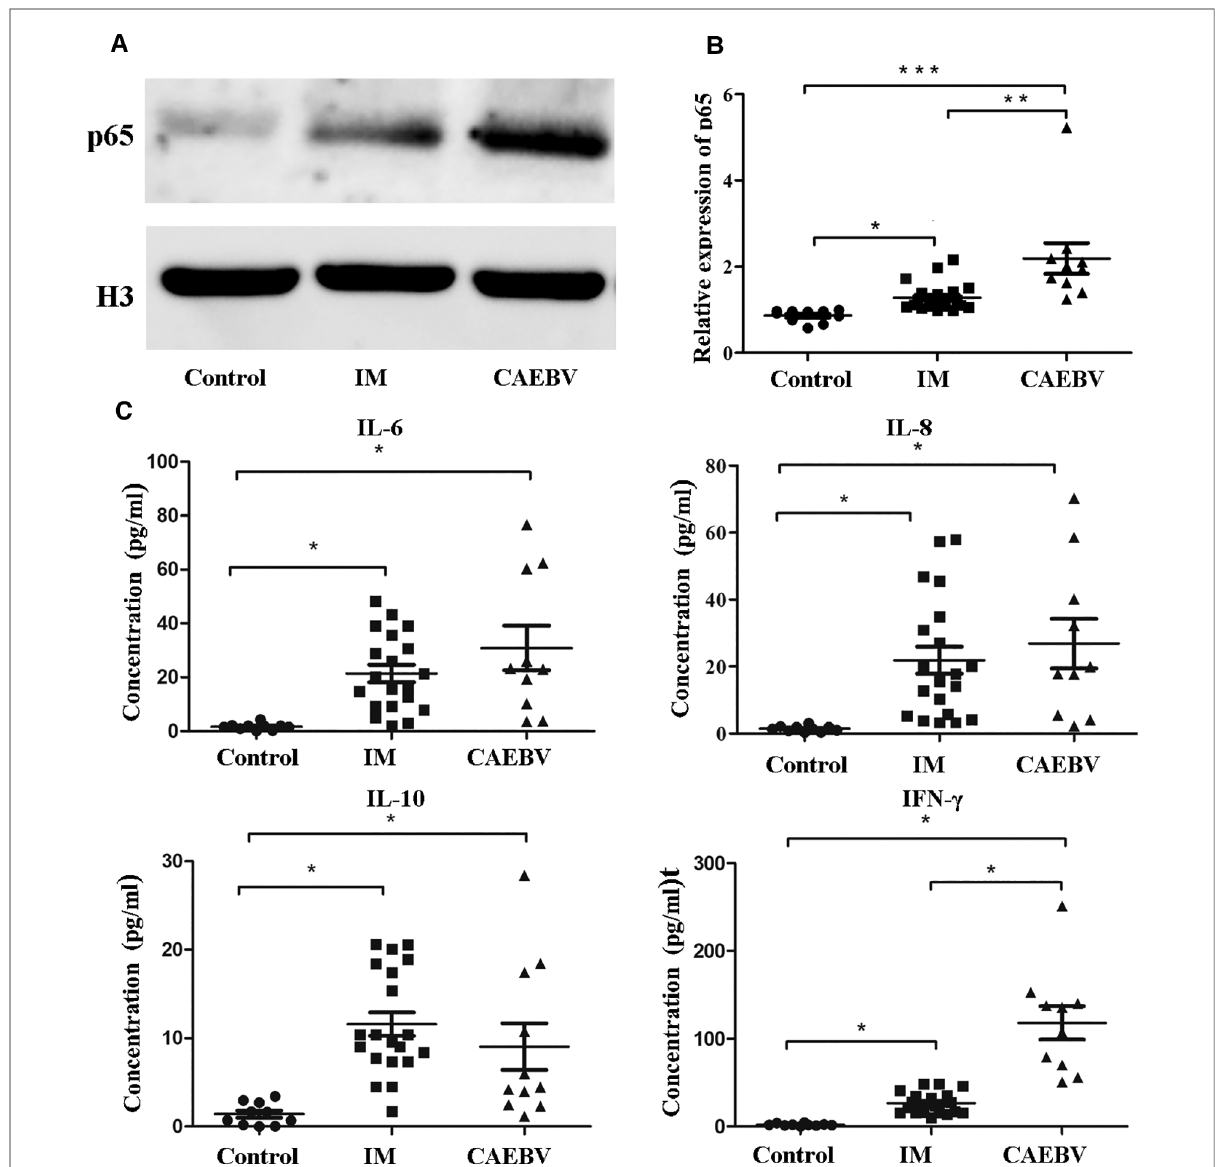
FIGURE 4 NF- κ B signaling activation in EBV-infected patients. ( A ) The protein levels of p65 in the nucleus by Western blot analysis. ( B ) The protein level of p65 in the nucleus in healthy controls (age-matched N =10), IM patients ( n =20) and CAEBV patients ( n =10). ( C ) Cytometric bead array (CBA) by fl ow cytometry showed that the expression levels of downstream cytokines, such as IL-6/IL-8/IL-10 and IFN- γ , were measured in serum obtained from healthy controls (age matched, n =20) and IM patients ( n =20) and CAEBV patients ( n =10). (* p <0.05 ** p <0.01 and *** p <0.001 by Duncan ’ s